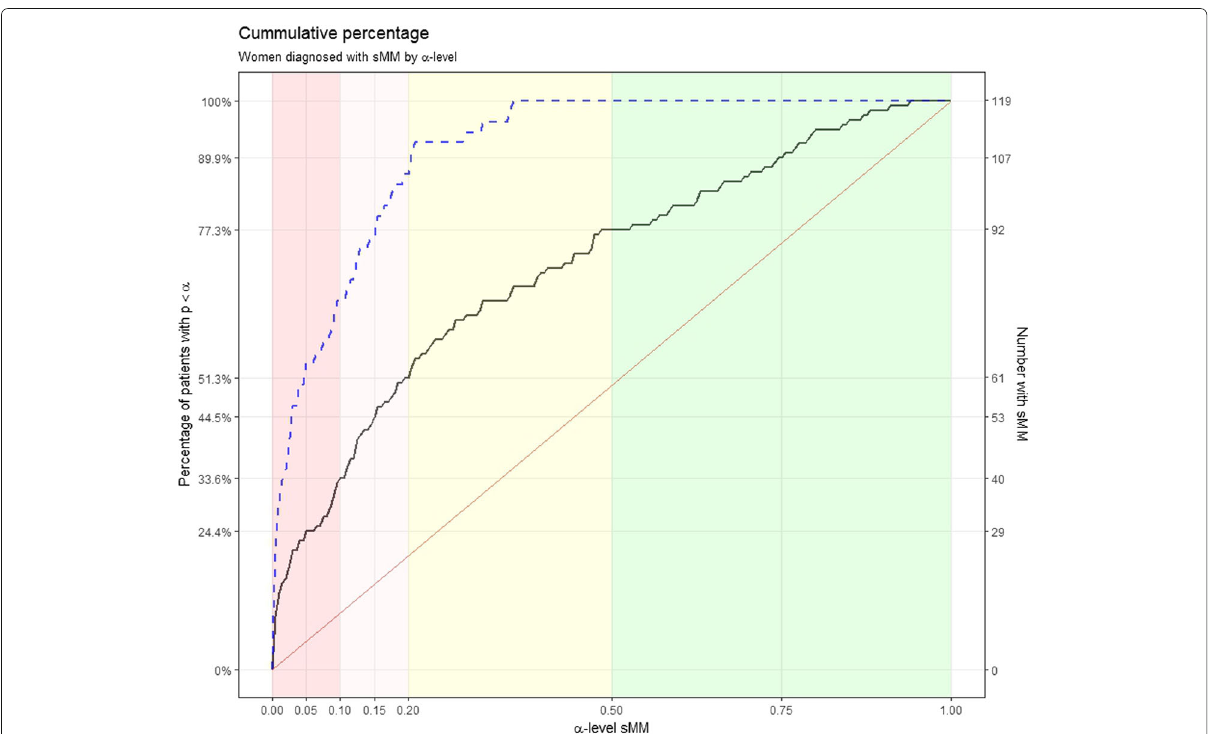
Fig. 4 Solid, black curve plots the percentage [number of women] on the left [right] y -axis receiving an sMM diagnose by α -level on the x -axis. The dashed, blue curve plots the percentage of women with a 2 MRM diagnosis that receive an sMRM( α )-diagnosis. The red line represents the expected 3 distribution, given that all women satisfy the test’s null hypothesis of non-association (i.e. constant μ ); as such the areas between the solid black curve and the red line can be interpreted as a measure of the aggregated association between menstruation and migraine in the patient population